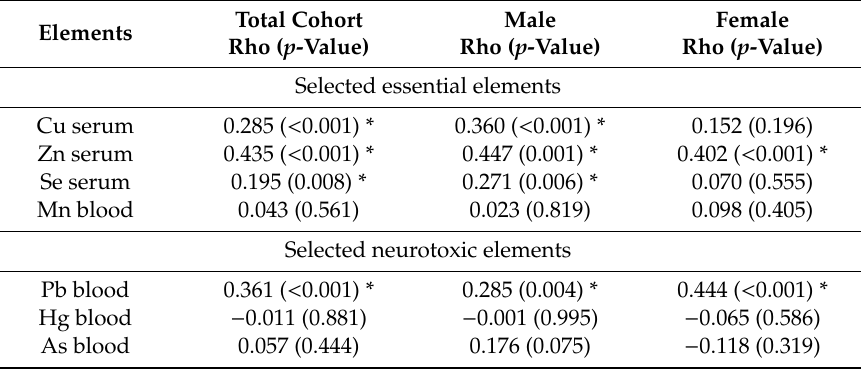
Table 5. Spearman’s association between prenatal exposure to Al and sex-dependent response for essential and neurotoxic elements at